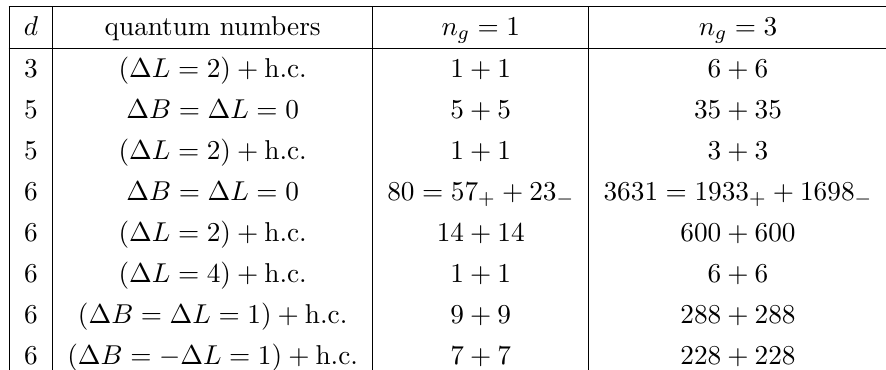
Table 3 . Number and quantum numbers of operators in LEFT of dimensions three, five, and six. The first column gives the operator dimension d , and the second column gives the ∆ B and ∆ L quantum numbers. The third and fourth columns list the number of Hermitian operators in LEFT for n g = 1 and n g = 3 generations of fermions, split according to their sign under CP .